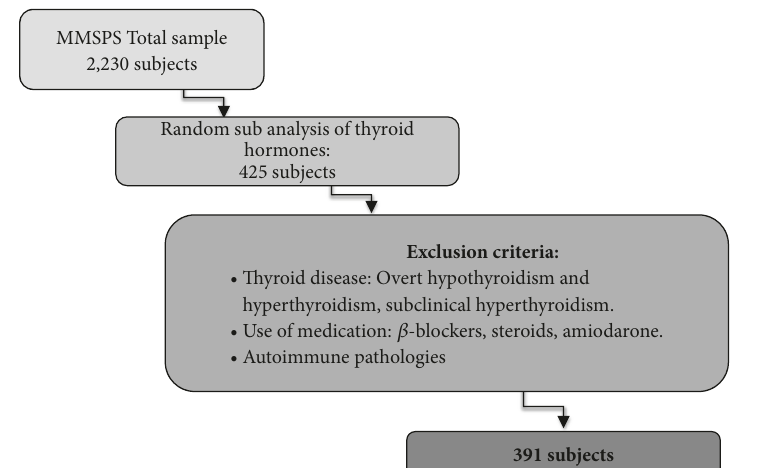
Figure 1: Algorithm for selection of the patients for subclinical hypothyroidism evaluation in adults from Maracaibo City,